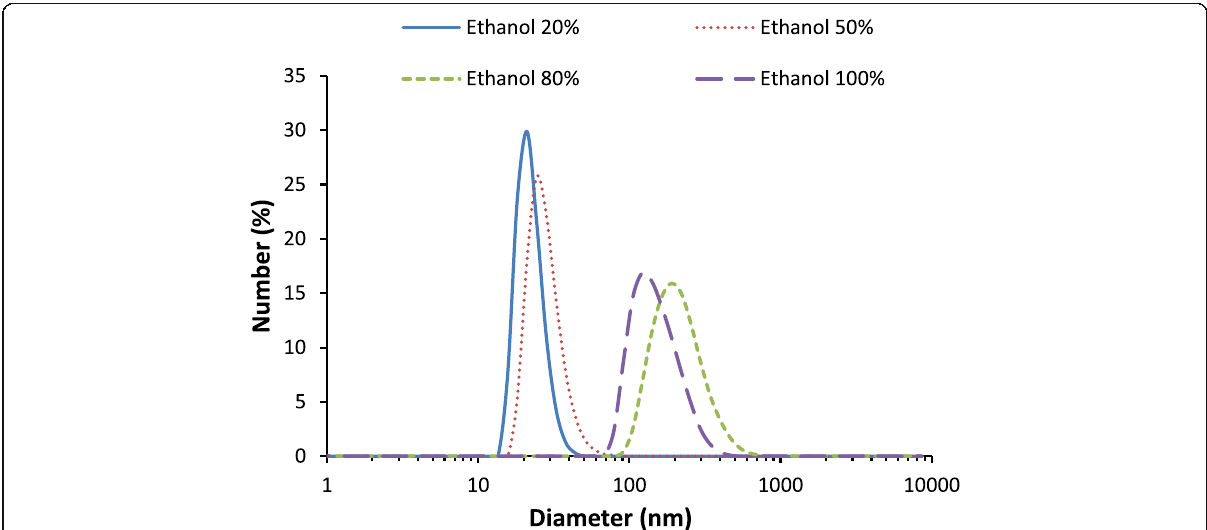
Fig. 2 DLS size distribution trends of GNPs particles in 20%, 50%, 80%, and 100% volume percentage of ethanol to water binary solvent